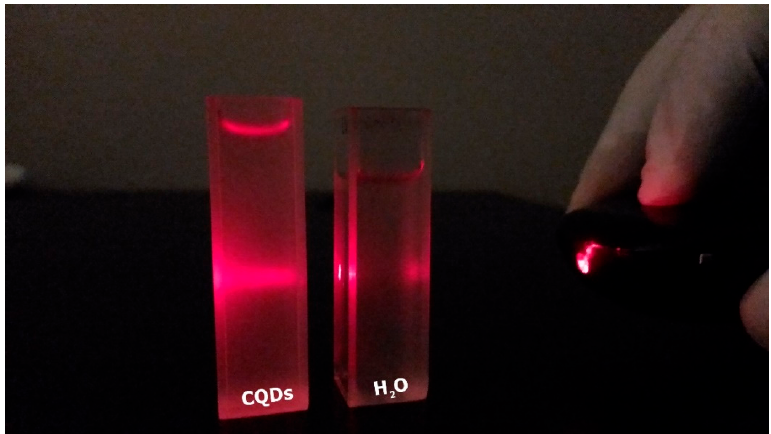
Figure 10. Tyndall effect in a colloid containing carbon nanoparticles.